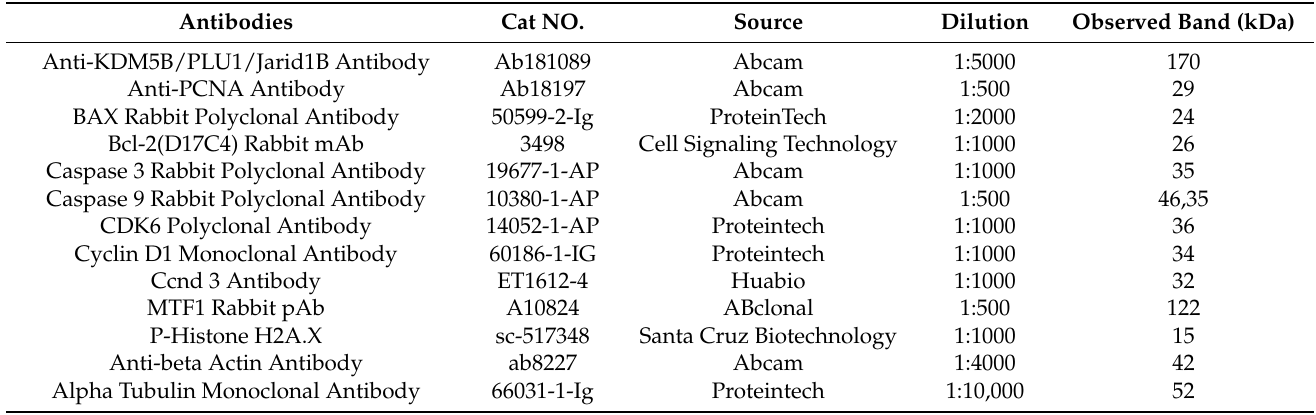
Table 3. Details of specific antibodies used for Western blot in the